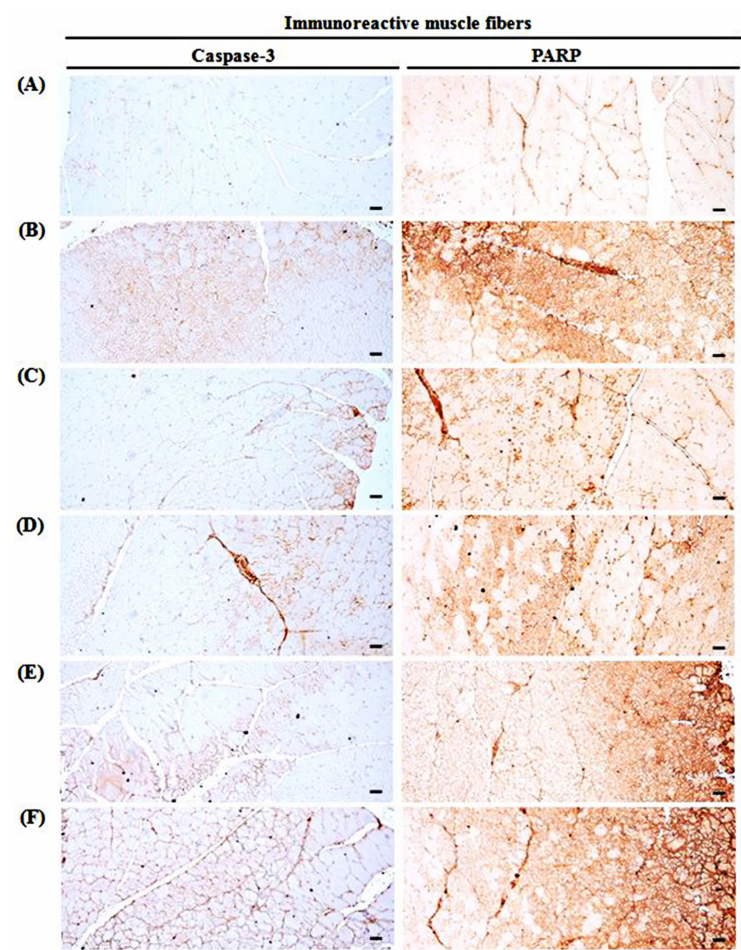
Figure 8. Representative gastrocnemius muscle caspase-3 and PARP-immunoreactivity. ( A ) Intact vehicle control (distilled water administered and treated with saline). ( B ) GLU control (distilled water administered and treated with DEXA). ( C ) Oxymetholone (50 mg/kg oxymetholone administered and treated with DEXA as reference). ( D ) TCcp500 (500 mg/kg TCcp administered and treated with DEXA–higher dose treated mice). ( E ) TCcp250 (250 mg/kg TCcp administered and treated with DEXA–middle dose treated mice). ( F ) TCcp125 (125 mg/kg TCcp administered and treated with DEXA–low dose treated mice). TCcp = tart cherry (Fruit of Prunus cerasus L., Rosaceae) concentrated powder. GLU = glucocorticoid. DEXA = dexamethasone. PARP = cleaved poly (ADP-ribose) polymerase. All avidin-biotin complex methods. Scale bars = 40 µ